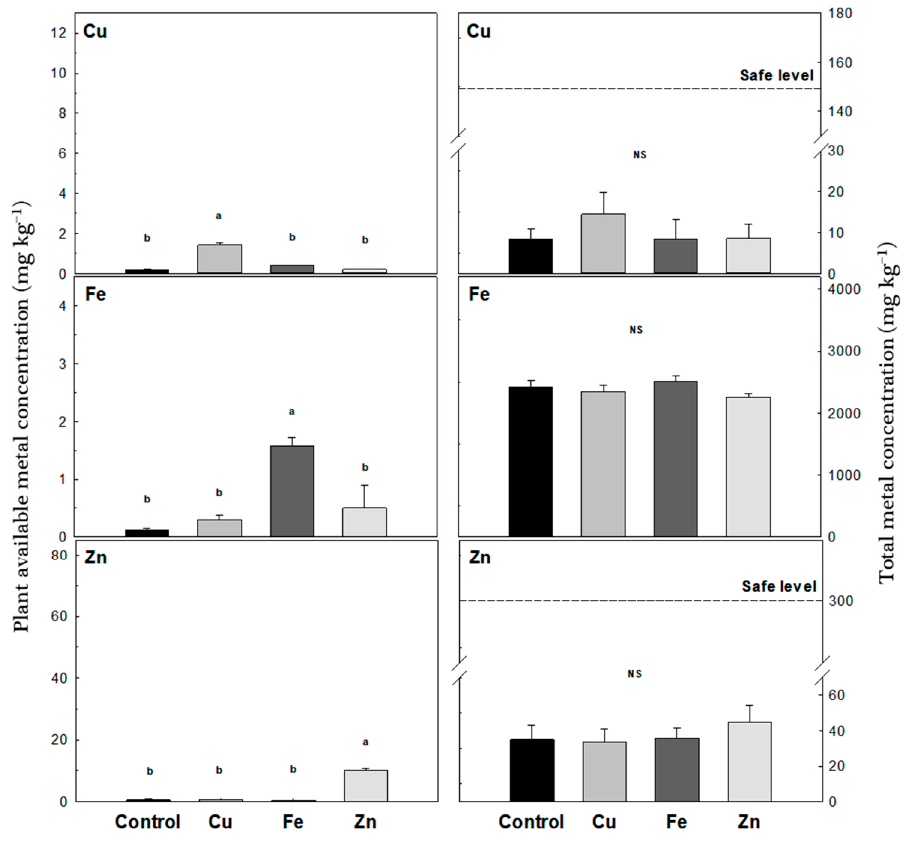
Figure 5. Concentration of plant-available metals and total metals in soils amended with different metals at harvest time in Year 2 (Dashed lines denote safe levels of Cu and Zn established by the Korean Soil Environmental Conservation Act). Different lowercase letters denote significant difference at p < 0.05